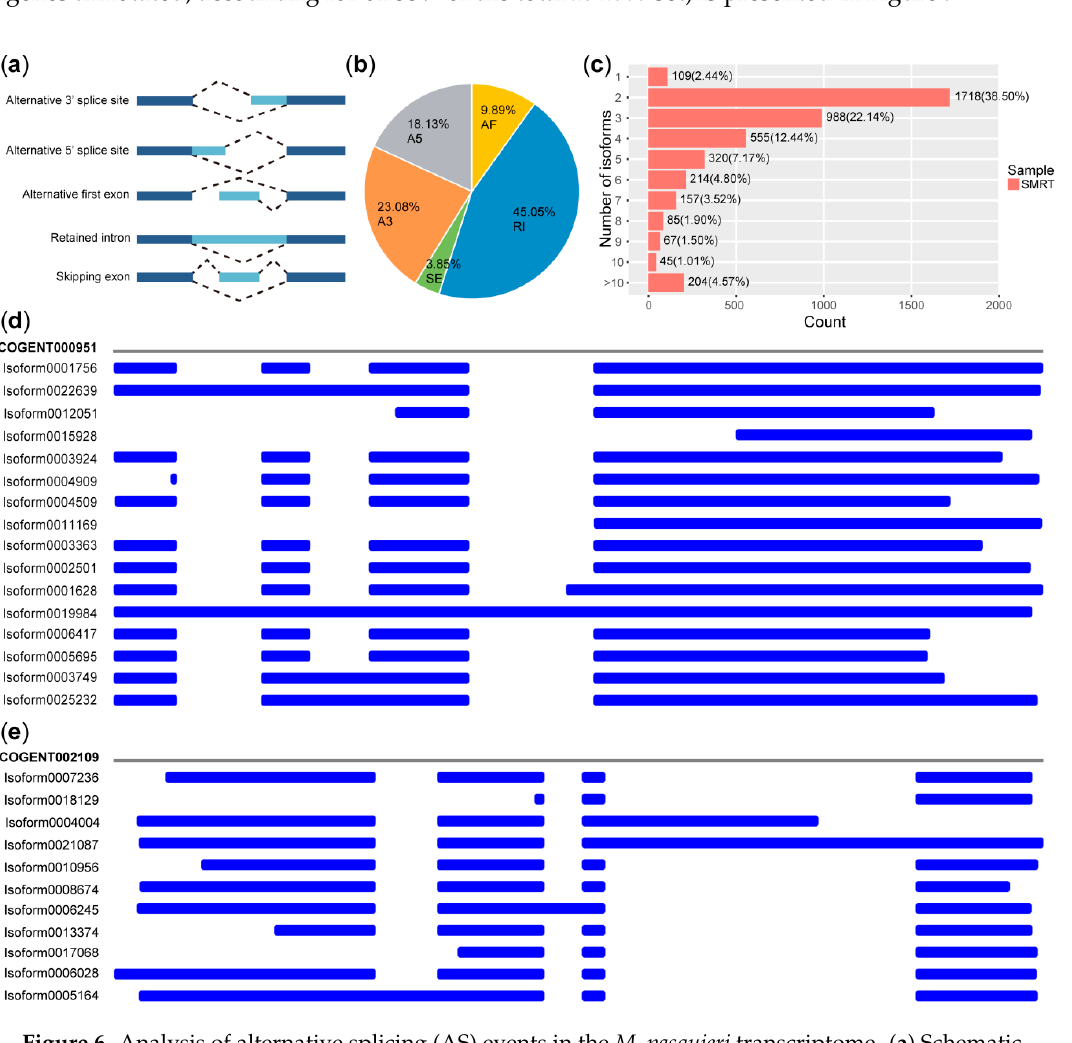
Figure 6. Analysis of alternative splicing (AS) events in the M. pasquieri transcriptome. ( a ) Schematic representation of five AS modes. ( b ) The number and percentage of different types of AS events detected by PacBio. A3, alternative 3 ′ splice site; A5, alternative 5 ′ splice site; AF, alternative first exon; RI, retained intron; SE, skipping exon. ( c ) Statistics for the isoforms of some genes. ( d ) Sequence analysis of different COGENT000951 isoforms. ( e ) Sequence analysis of different COGENT002109 isoforms.